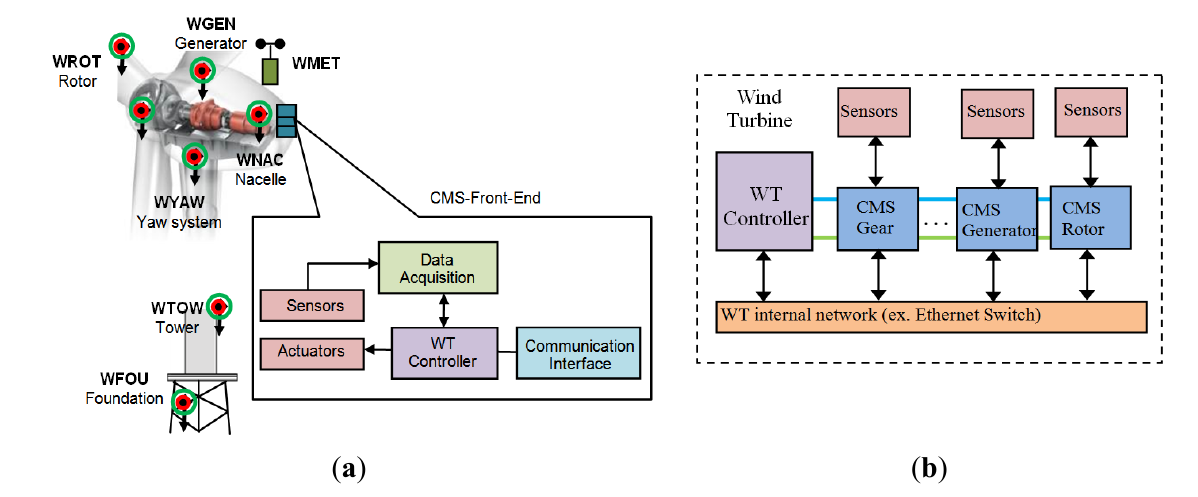
Figure 4. ( a ) Structure of the turbine area network (TAN); ( b ) Communication network model inside a wind